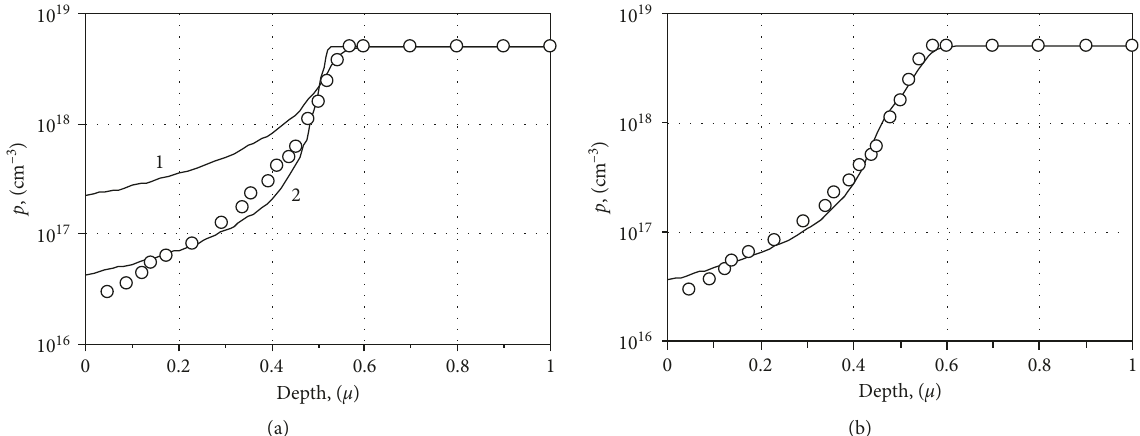
18 cm 3 annealed at 150 ° C for 30 min. (a) Fitting by in-diffusion of one kind of H + . B (cid:28) 5 × 10 1 s 1 , X 1 s 1 , X 8 10 4 cm 21.2; curve 2: with D + K 1.4 10 4 cm 115. (b) Fitting by in-diffusion of two kinds of H + − (cid:28) × (cid:28) (cid:28) × (cid:28) − − − −